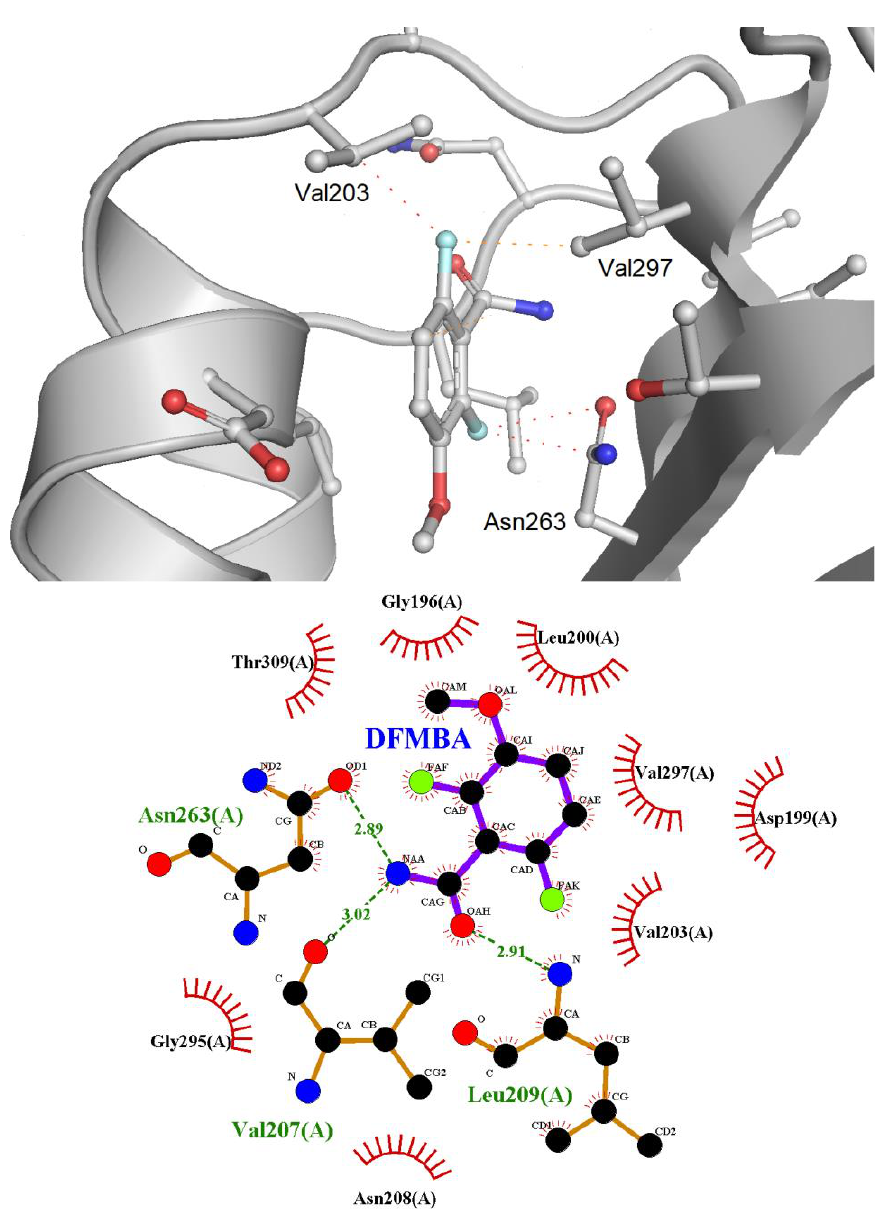
Figure 2. Visualization of the interactions revealed by the Arpeggio server [24] indicated in red dashes of the fluorine atoms of the benzamide nucleus with residues of the FtsZ protein and 2D representation of DFMBA in the allosteric pocket (PDB: 6YD1 [11]).